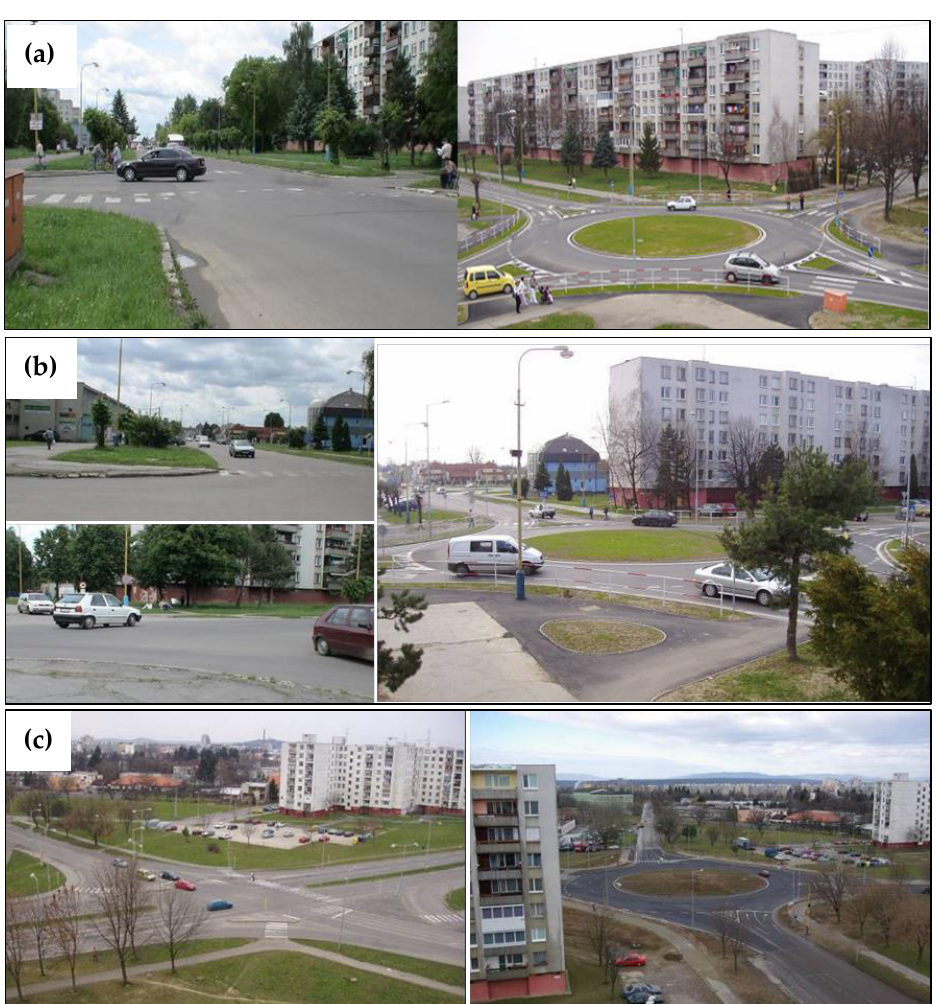
Figure 2 . Photos of the intersections ( a ) R1, ( b ) R2 and ( c ) R3 before ( left ) and after ( right ) reconstruction to roundabouts in Michalovce City.